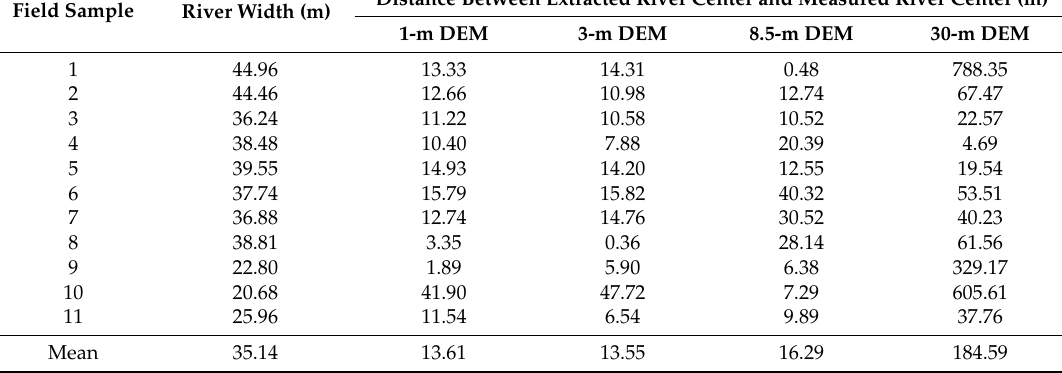
Table 2. Measured river widths and accuracy assessment of the extracted river centers derived from the four different DEMs at the 11 sample